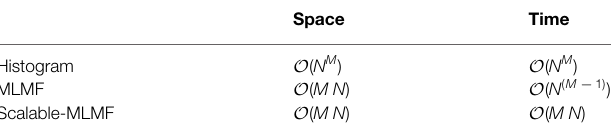
Frontiers in Robotics and AI |